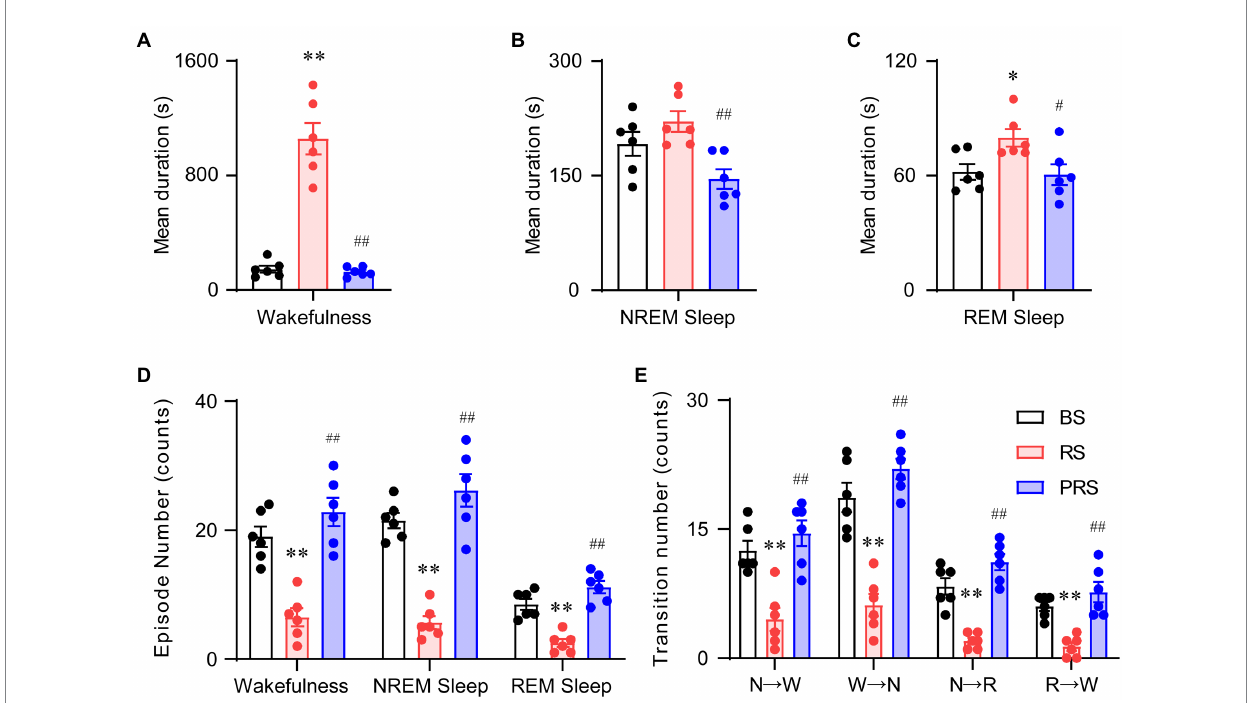
FIGURE 4 Sleep–wake architectures in the baseline, RS, and PRS conditions during ZT 3–5. Mean durations of wakefulness (A) , NREM sleep (B) , and REM sleep. (C) Episode numbers of each stage (D) and stage transitions between stages (E) during the 2 h in the lights on period (ZT 3–5) after restraint stress. * p < 0.05, ** p < 0.01 versus baseline, # p < 0.05, ## p < 0.01 versus RS, n = 6. BS, baseline; RS, restraint stress; PRS, post-restraint stress. R, REM sleep; S, NREM sleep; W,